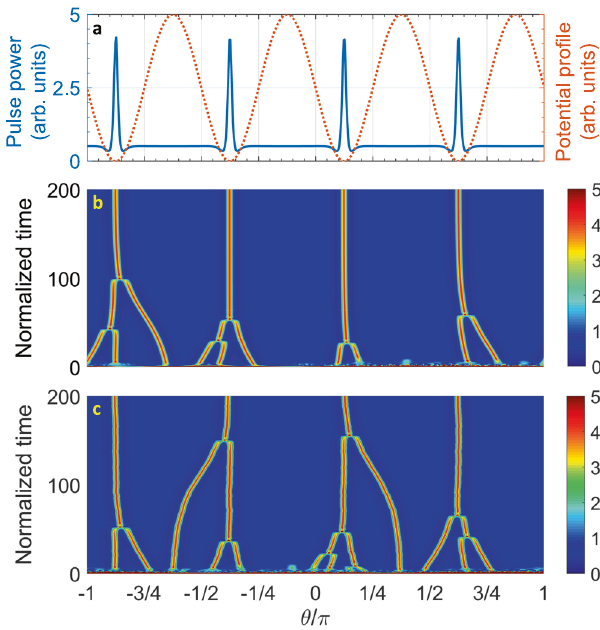
Fig. 3 Stability of states in a Kerr cavity driven by a temporally structured pump. a Steady-state pulse train waveform per round-trip time (left axis, solid blue) and the modulation-induced potential pro fi le (right axis, dashed orange). The soliton peaks settle in the potential minima as predicted by the theoretical model. b Temporal evolution of the soliton peaks emerging from an energetic random initial waveform whose steady state is plotted in a . Multiple solitons form in the cavity and converge under the drag of the modulation potential. Numerical parameters used in a , b are α = 2.1, ω M = 4 D 1 , d 2 = − 5 × 10 − 3 , d m = 0 ( m ≥ 3), f 0 = 1.35, and δ = 0.4. c Same as b but for non-ideal locking of the modulation frequency M to 4 D 1 ; ω M /4 − D 1 is taken to be a noisy signal of uniform distribution with zero mean, 2% half width at half-maximum standard deviation, and temporal fl uctuations on the order of the integration step ( (cid:2) t = 400).